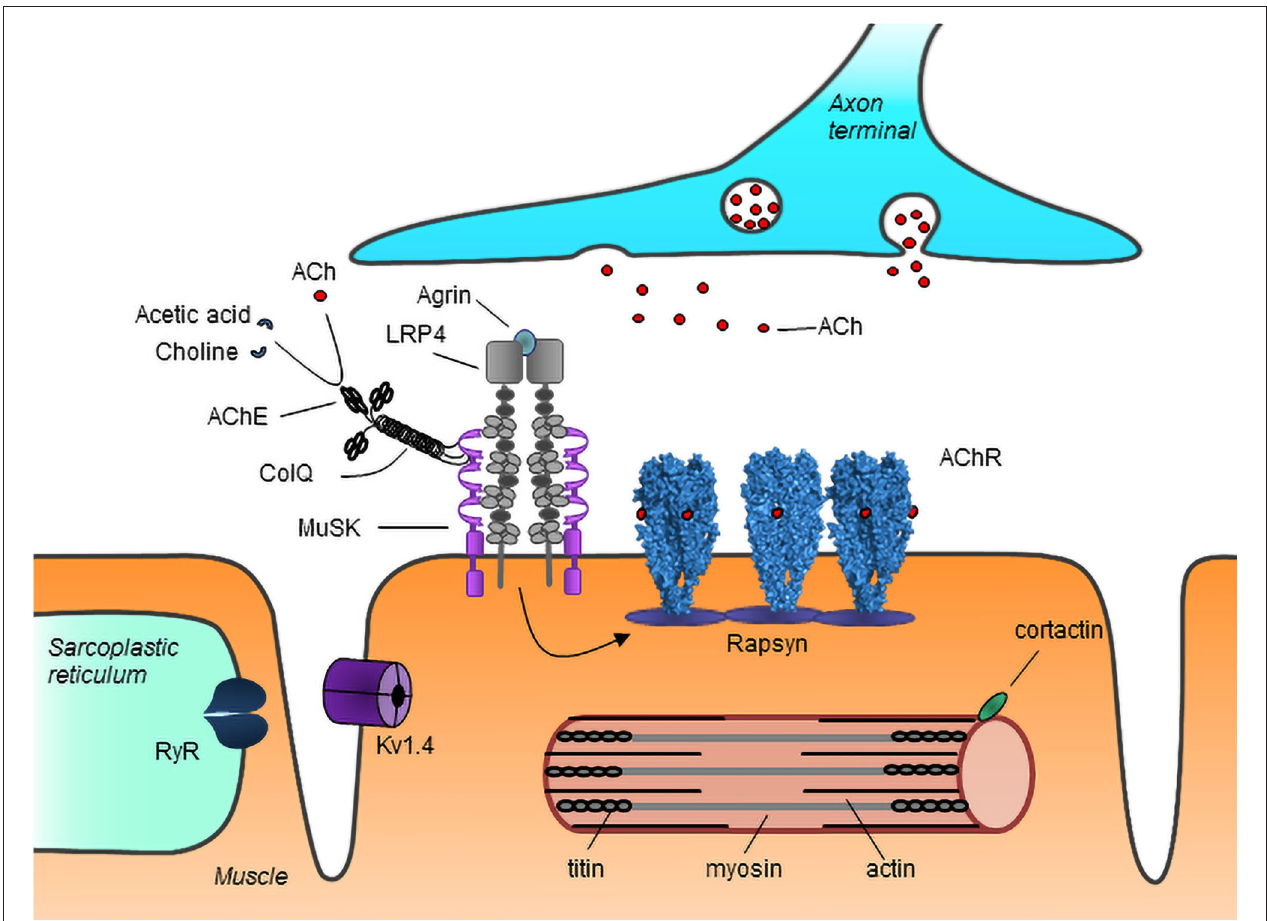
FIGURE 1 | Schematic representation of major neuromuscular junction and myotube proteins targeted by autoantibodies in MG. Neuron-released agrin activates LRP4 on the muscle membrane, initiating a pathway which via MuSK leads to rapsyn-dependent AChR clustering at the NMJ. Acetylcholine (ACh) released from the nerve terminal binds to AChRs causing their activation. ACh is broken down by AChE into choline and acetate, thus terminating its action. AChR, acetylcholine receptor; MuSK, muscle specific kinase; LRP4, low-density lipoprotein receptor-related protein 4; RyR, ryanodine receptor; ColQ, collagen Q; AChE, acetylcholinesterase; Kv1.4, voltage gated potassium channel 1.4. Image from Lazaridis and Tzartos